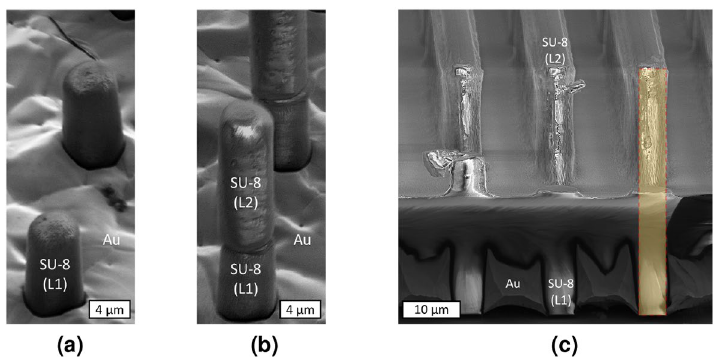
Figure 5. SEM images of SU-8 micropillar and line gratings through the self-aligned multi-layer fabrication process. ( a ) Demonstration of SU-8 micropillars before the definition of the second SU-8 layer, and ( b ) the same SU-8 micropillars after the second SU-8 layer (micropillars) is fabricated following the self-aligned backside UV lithography. ( c ) Illustration of a two-layer SU-8 lamella structure—for line